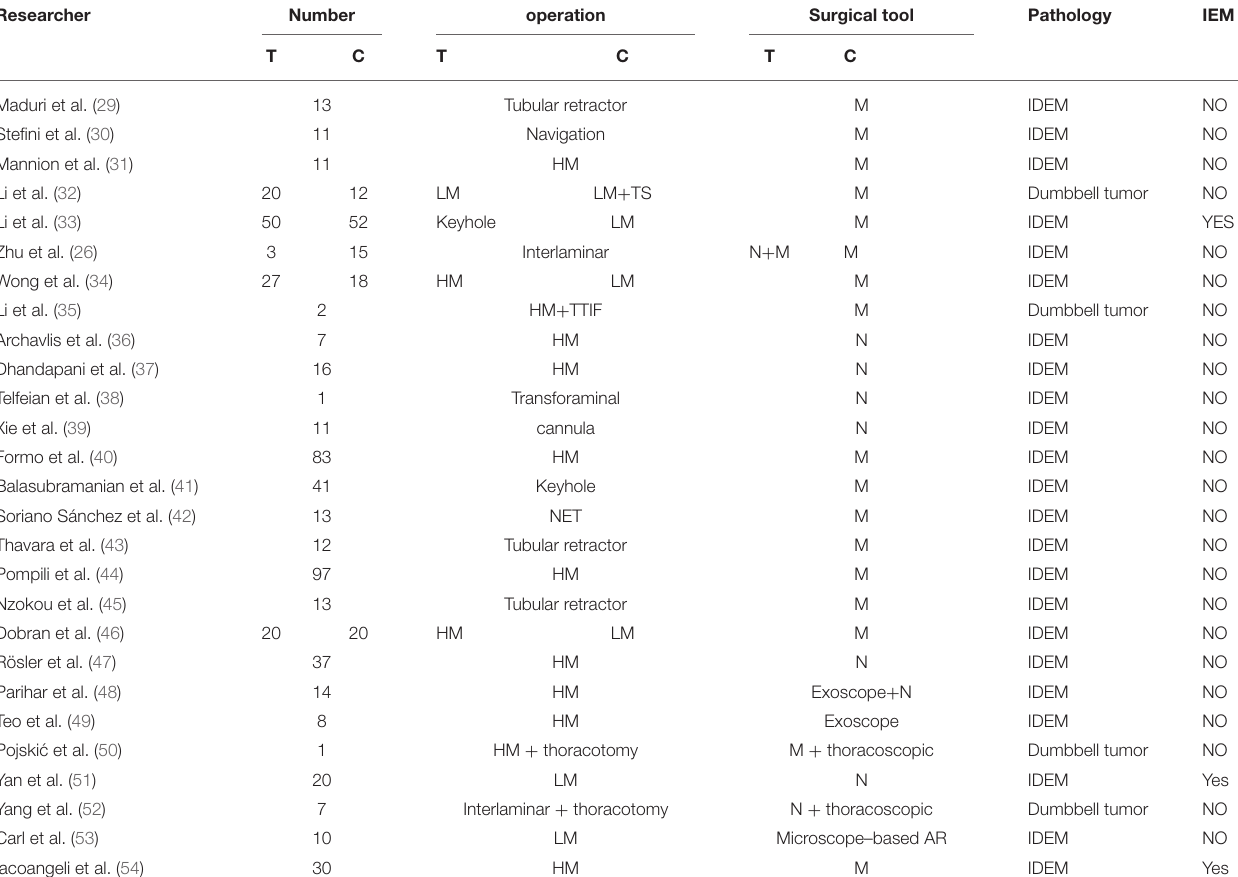
TABLE 5 | Surgical approachs for patients with intraspinal tumors. Researcher Surgical tool